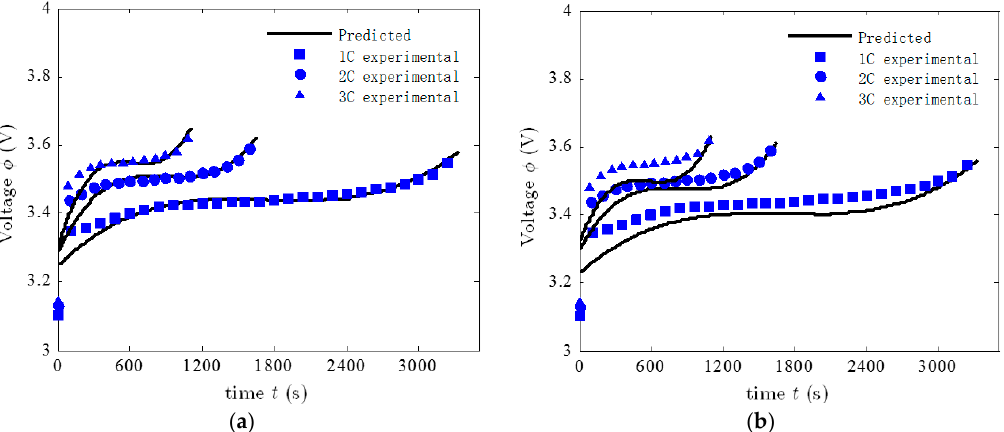
Figure 9. Comparison between experimental and predicted charge voltage curves at charge rates of 1C, 2C, and 3C by ( a ) weighted PSO-LM; and ( b ) method of trial and error.